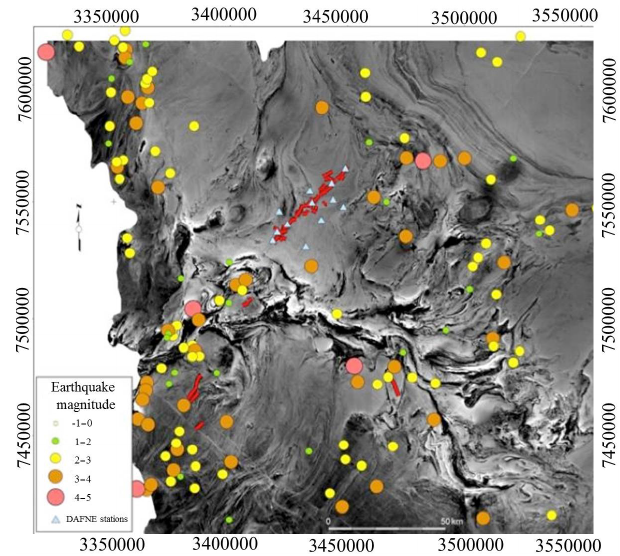
Figure 2. Position of DAFNE temporary array (blue triangles) on the aeromagnetic field map of Finland. Epicentres of local earth- quakes detected by regional seismic networks in Fennoscandia prior to DAFNE/FINLAND experiment are shown by circles with size proportional to the magnitude of the event. Postglacial faults in the area are shown by red lines. The coordinate system is the Finnish National Coordinate System